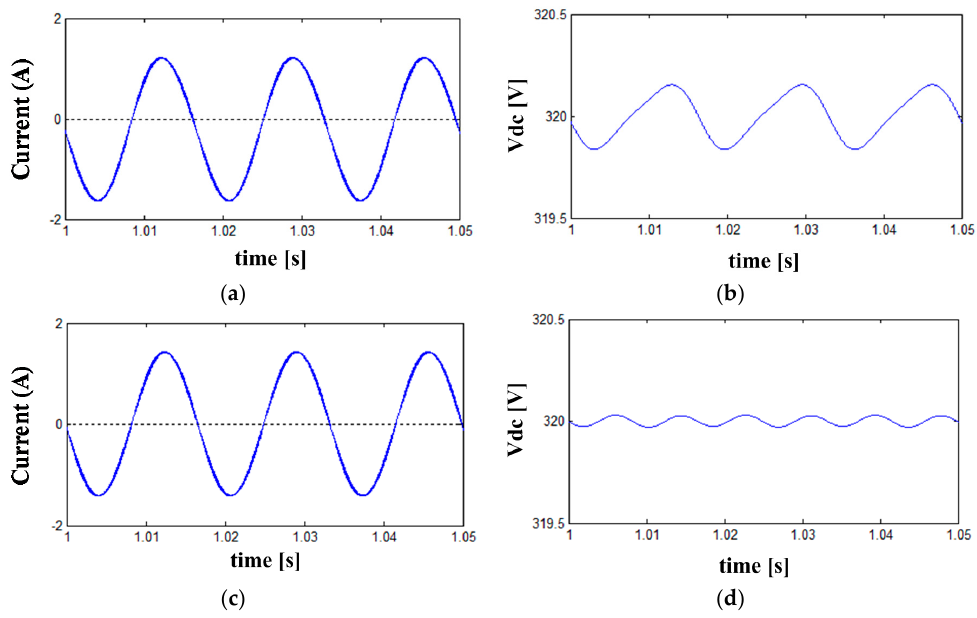
Figure 6. Simulation results of ( a ) phase current ( b ) DC-link voltage without DC offset compensation algorithm and ( c ) phase current and ( d ) DC-link voltage applying the proposed DC offset error compensation algorithm.